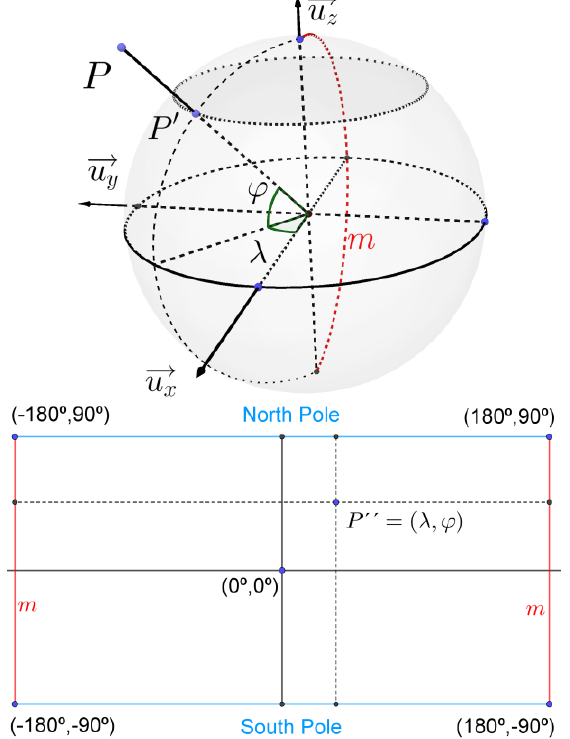
Figure 2 | Equirectangular perspective and flattening. 𝑃 maps to 𝑃′ on the sphere by central projection and onto 𝑃′′ on the rectangle of the perspective